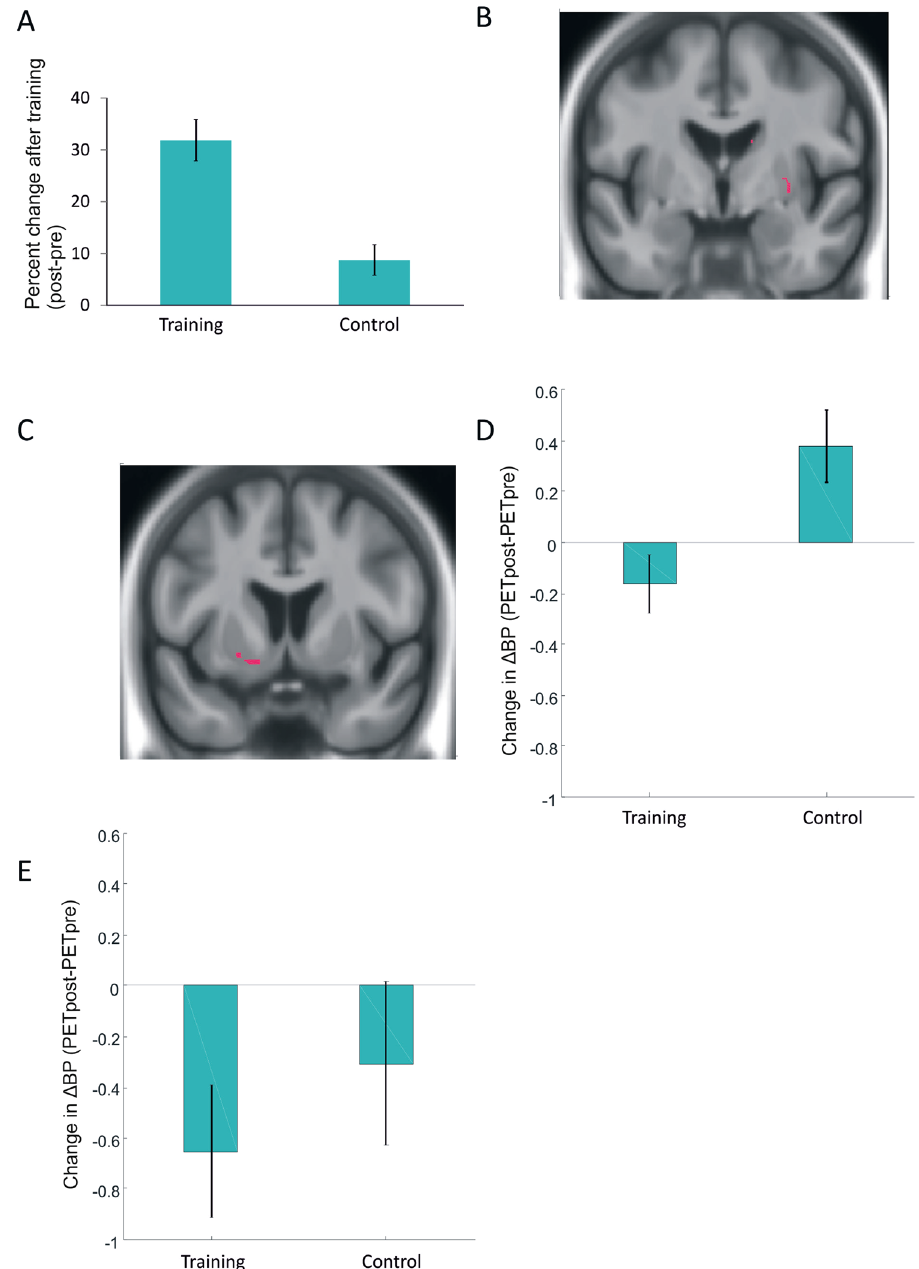
Figure 1. Behavioral and dopamine effects for the letter-memory criterion task. ( A ) Percent pre-post changes in letter memory. ( B ) Lower raclopride binding to striatal D2 receptors during letter memory compared to the control task before training in right striatum, reflecting greater DA release in response to the cognitive challenge (x,y,z = 14, − 3,18; 30, − 3, − 2). ( C , D ) A training-induced decrease of raclopride binding to D2 receptors was found in left striatum ( − 18, 6, − 12). ( E ) Training-related changes in raclopride binding to striatal D2 receptors in the peak region observed by Bäckman et al . 18 . Error bars are standard